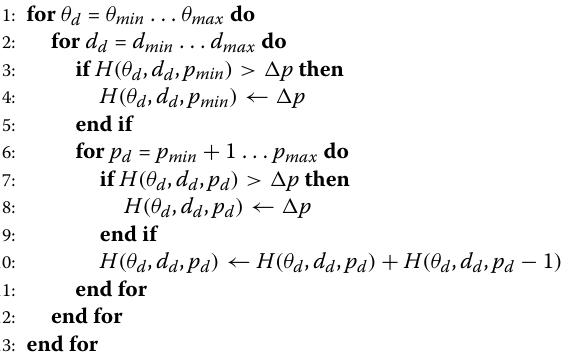
Algorithm 2 Second stage of the voting